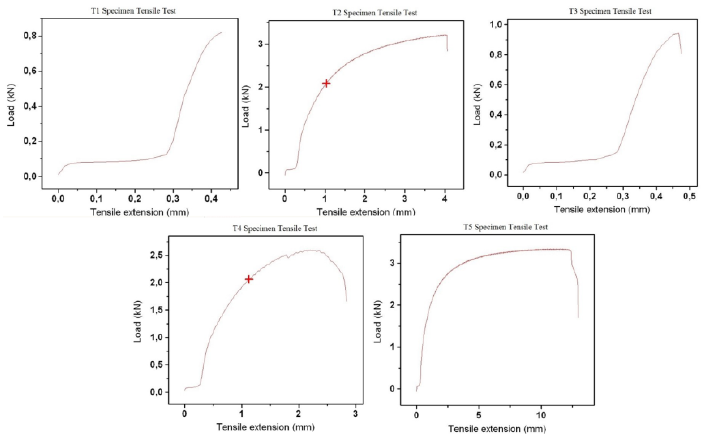
Figure 6. Force–extension curves of the failing results.